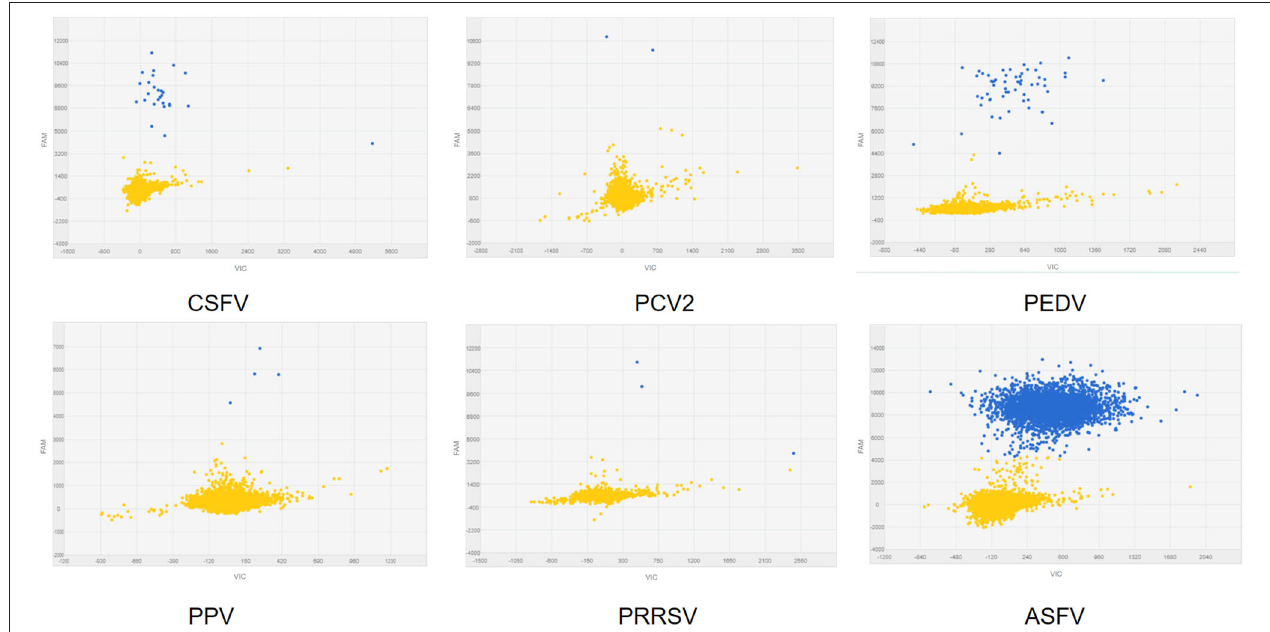
FIGURE 6 | The specificity of cdPCR assay. Only the ASFV pFastBacI-p72 standard plasmid was positive, i.e., nucleic acid templates of other pathogens were negative.